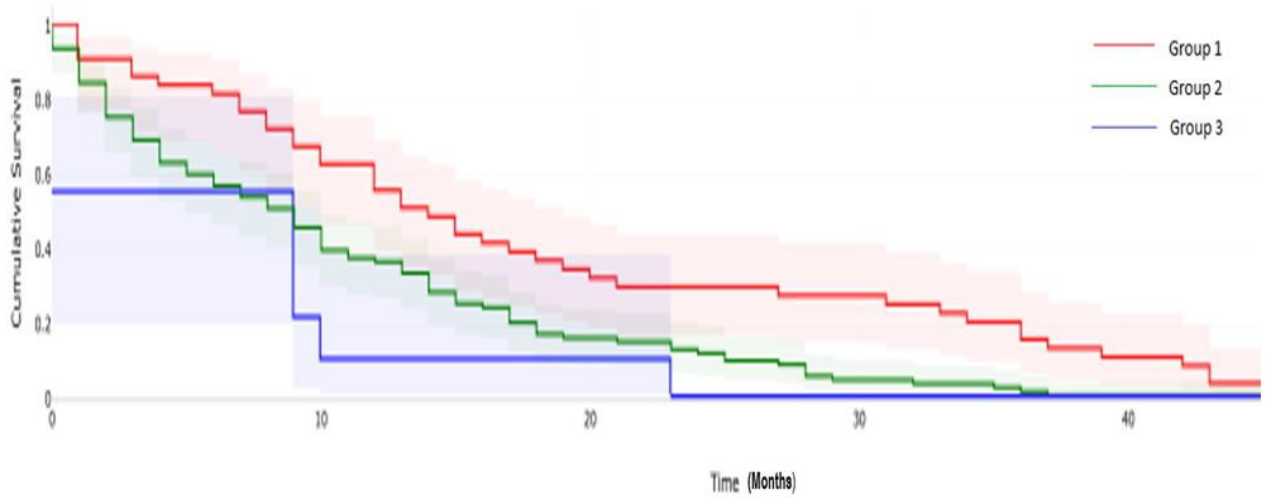
Figure 3. Overall survival based on next-generation sequencing (NGS) test result. p = 0.002 by log-rank test.